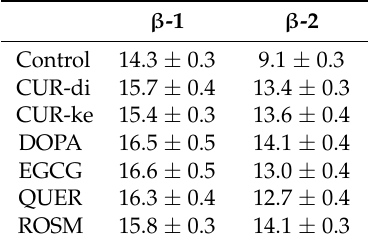
Table 3. Intersheet distance in the A β (1–40) oligomer double-layered